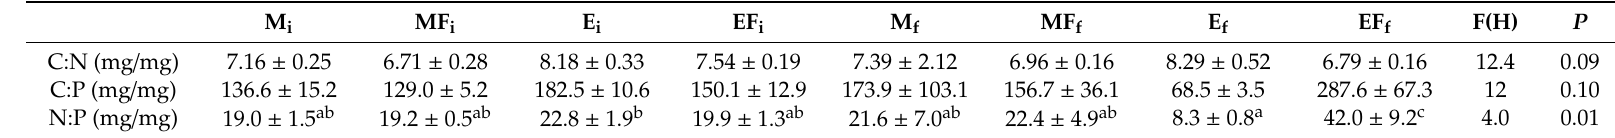
Table 1. Results of one-way ANOVA comparing means ( ± SE) of ratios of indicators of nutritive quality of seston in experimental mesocosms: E—eutrophic, M—mesotrophic, F—fish, i—initial (June) date, f—final (July) date, C—organic carbon, N—nitrogen, P—phosphorus, F—Fisher’s test, and its significance, P—significant values are given in bold); means labeled with the same letter are not significantly di ff erent at P < 0.05 after Fisher’s LSD post hoc test (in the absence of normal distribution, the Kruskal–Wallis test was